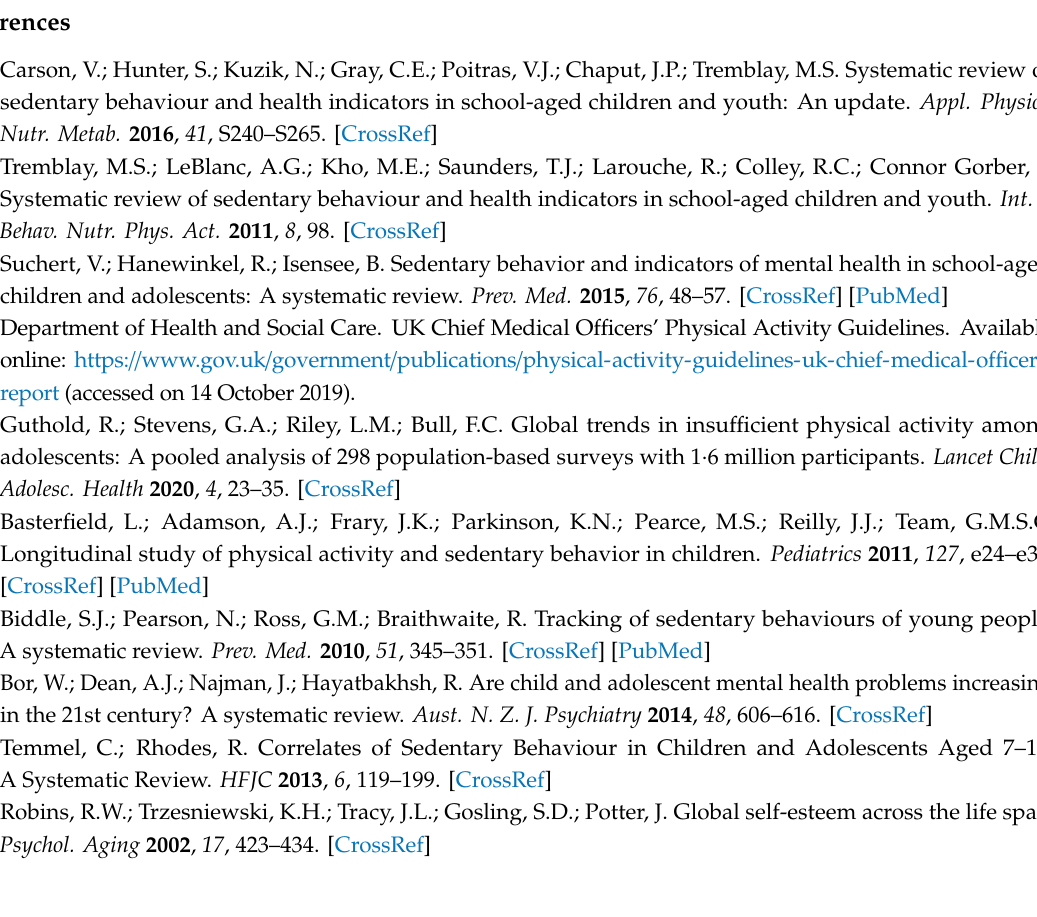
Table S1: Sociodemographic of children and parents, Table S2: Scores for psychosocial variables by gender and BMI category, Table S3: Proportion of sample scoring in each psychosocial